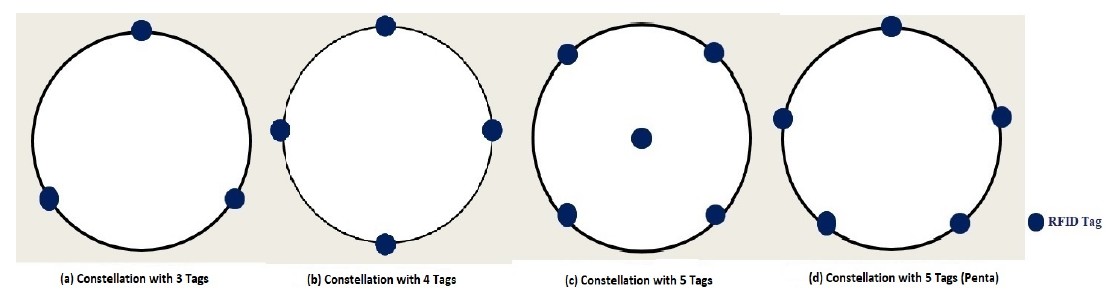
Table 1. The mean estimated distance errors for different constellations.